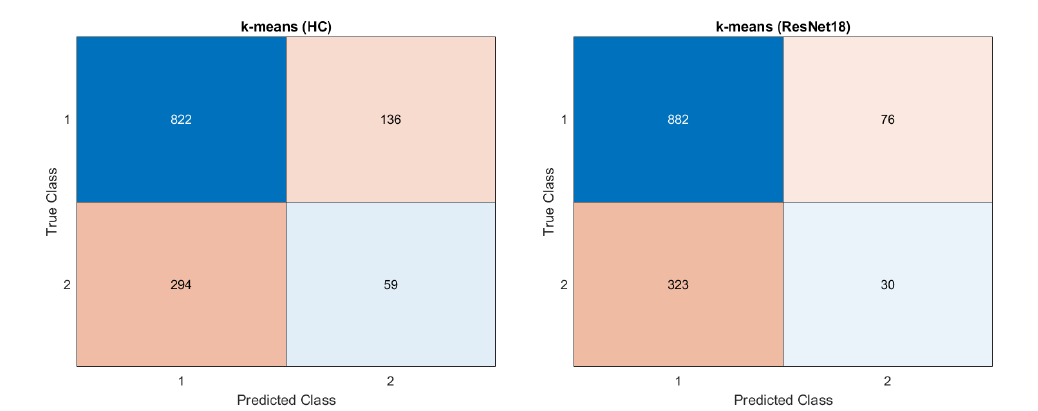
Figure A6. Confusion matrices for the k-means algorithm trained with handcrafted ( left ) and ResNet18 ( right ) features.